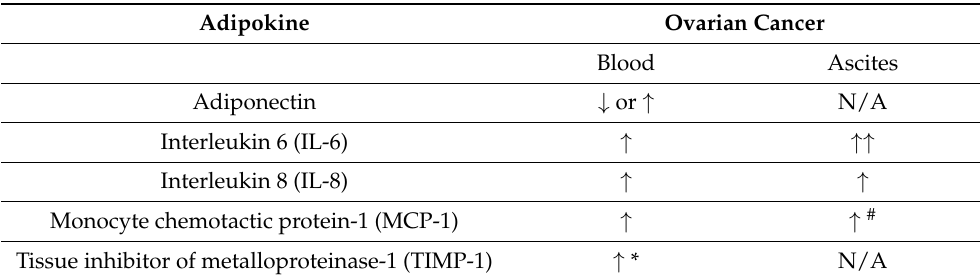
Table 10. Summary of the selected adipokine concentrations in the blood and ascites of patients with ovarian